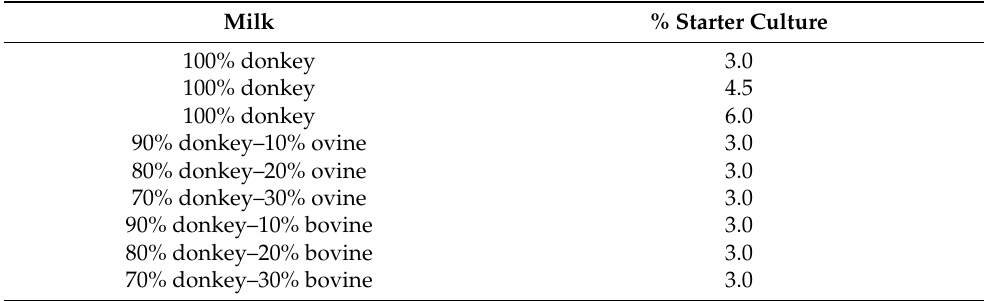
Table 6. Different milks and starter culture percentage used for fermented beverage production.